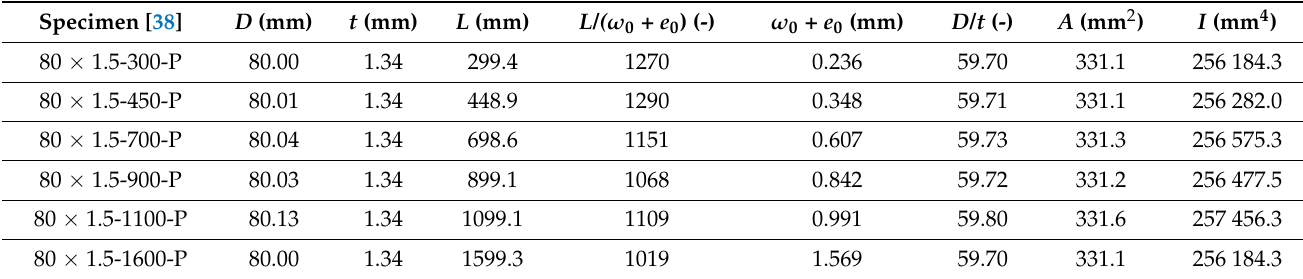
Table 6. Measured and calculated geometric properties of the cross-section set 80 × 1.5 CHS pin-ended columns (fer- ritic steel).